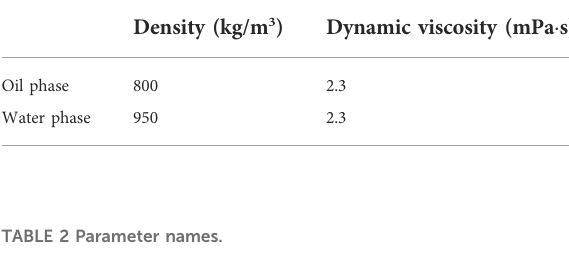
TABLE 1 Oil and water parameters.